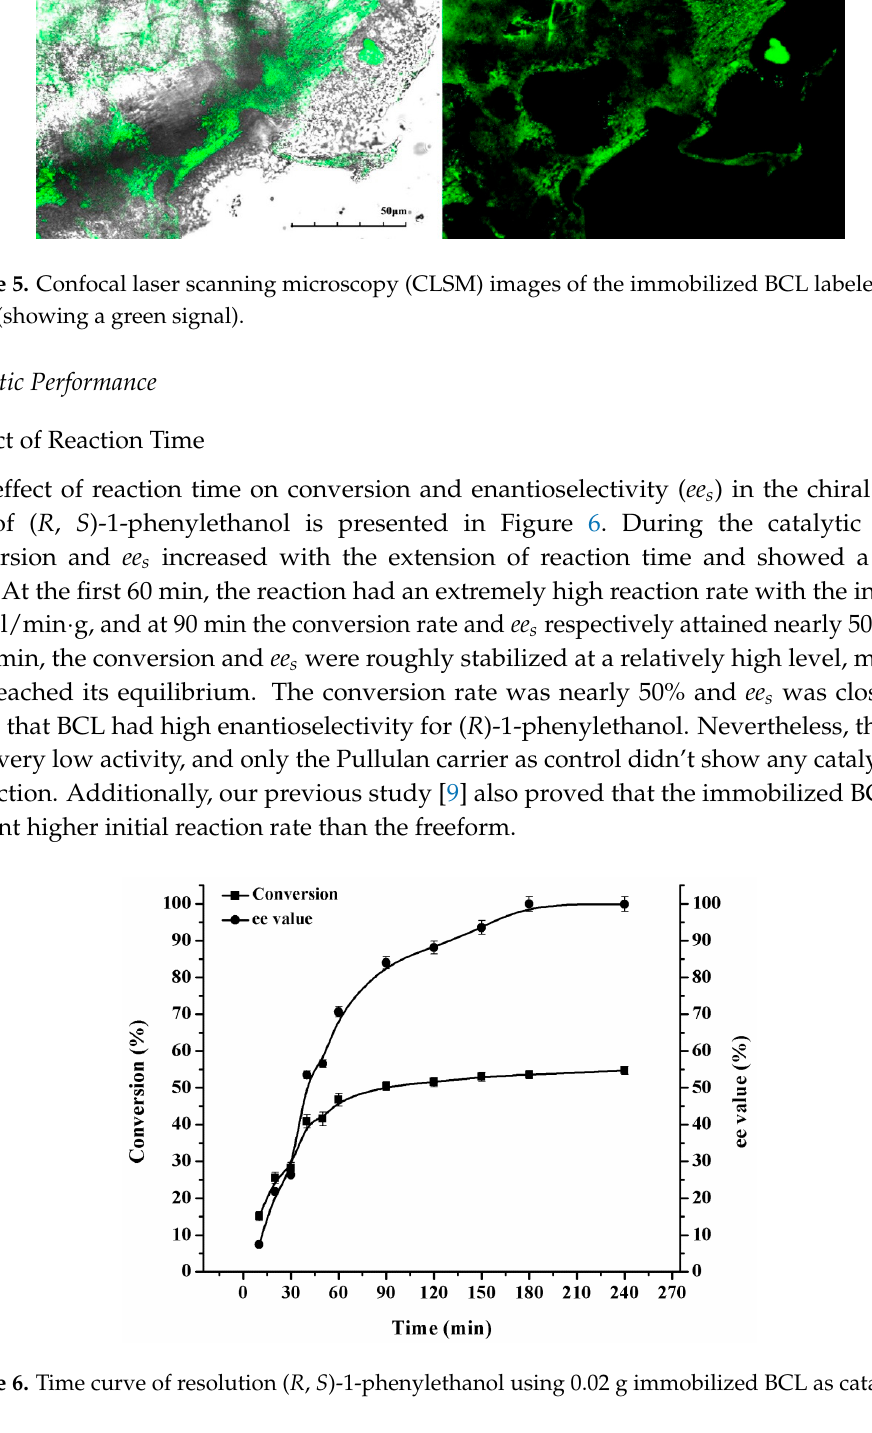
Figure 4. Effects of solution pH values (4–10) on the immobilization efficiency and ee value with